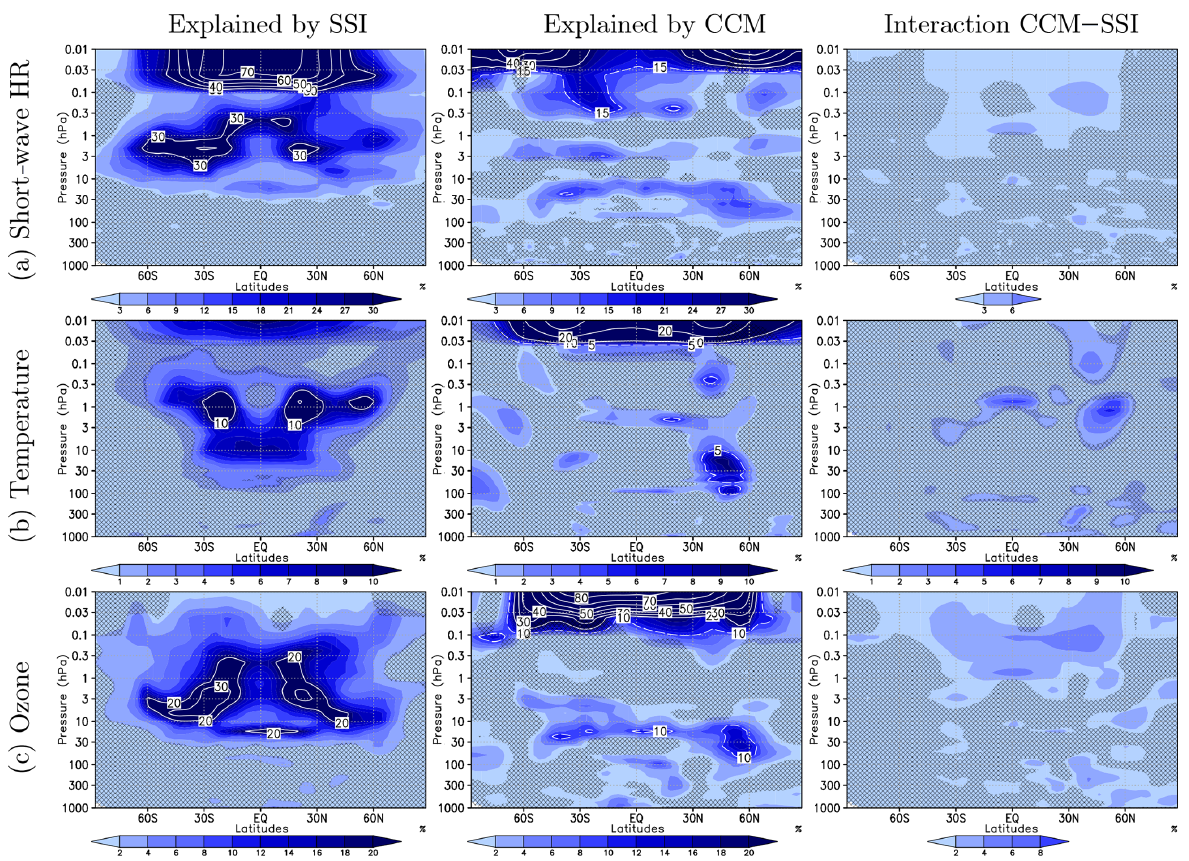
Figure 4. Left column: percentage of signal variance (square of white contours of Fig. 3) explained by systematic differences between forcing SSI data sets ( R a, B , Eq. A11, blue shading). The white contours indicate levels of explained variance larger than the range of shading. Middle column: as the left column but for systematic differences between CCMs ( R a, A , Eq. A11). Right column: as the left column but for signal variance explained by the interaction of the CCM and the SSI data set treatments ( R a, AB , Eq. A12). The grey hatching masks areas where the ratio of explained variance does not pass a test for statistical significance ( p >